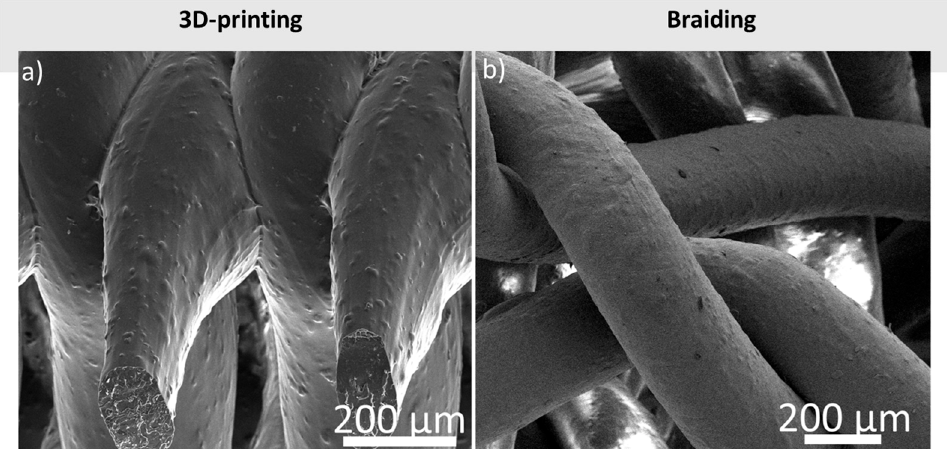
Figure 5. Morphology of the surface of the ( a ) 3D-printed scaffold containing PLA+2[(f-EG)+Ag], and ( b ) braided scaffold with PLA+1[(f-EG)+Ag]. Table 1. Mean porosity, pore size, and filament thickness of the 3D-printed and braided scaffolds, calculated from the micro-CT